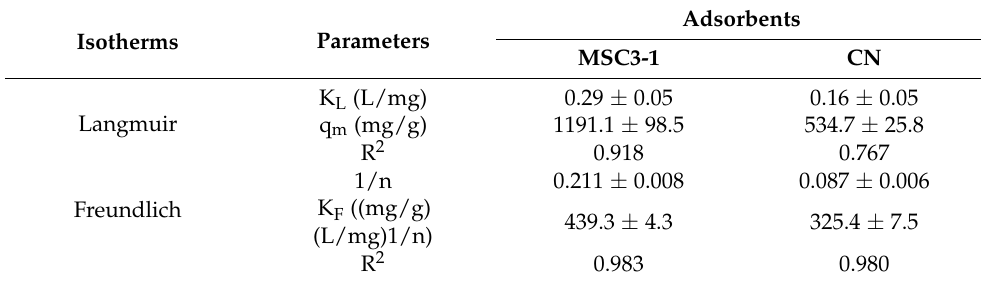
Table 2. Isotherm parameters of MCS3-1 and CN adsorption of MB.